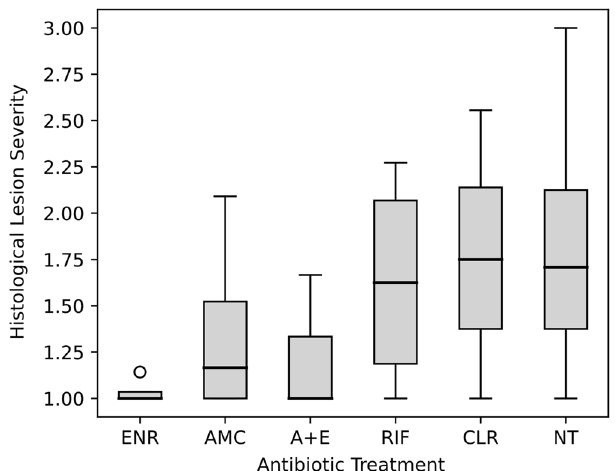
Figure 7. Boxplot of the average histological lesion severity for each antibiotic treatment administered. The bold line indicates the median, the interquartile range (25th to 75th percentile) is represented by the grey shading, the whiskers represent the minimum and maximum values, and the outlier is shown by the circle. ENR enrofloxacin; AMC amoxicillin-clavulanic acid; A + E amoxicillin-clavulanic acid and enrofloxacin; RIF rifampicin; CLR clarithromycin; NT no treatment.